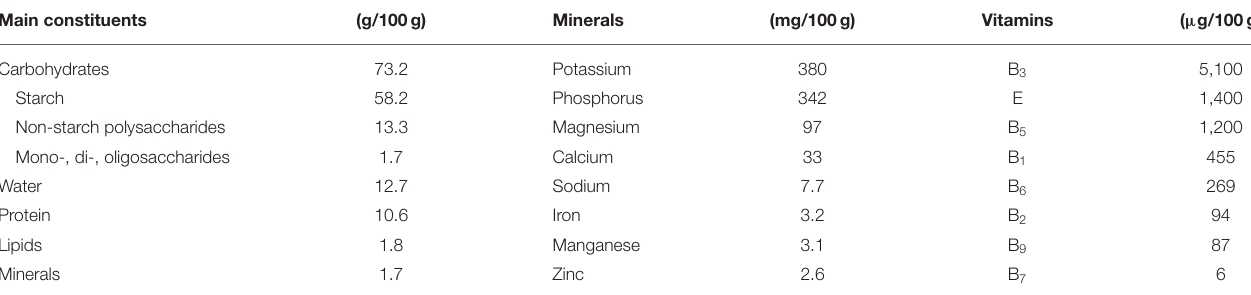
TABLE 1 | Average contents of grain constituents of common wheat (21). Main constituents